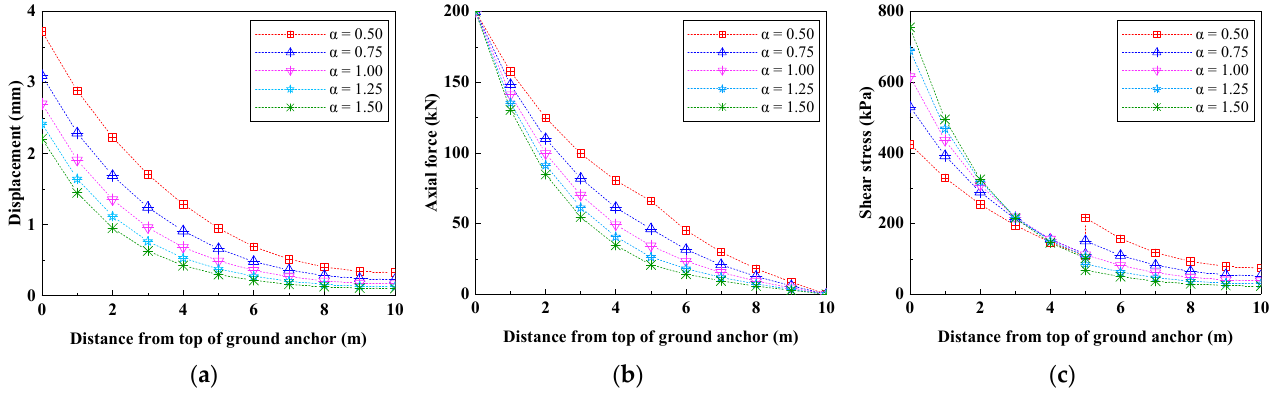
Figure 6. Effect of shear modulus change of Stratum-1 on mechanical behavior of ground anchor. (Case 1: condition 1) ( a ) displacement distribution curve; ( b ) axial force distribution curve; ( c ) shear stress distribution curve.